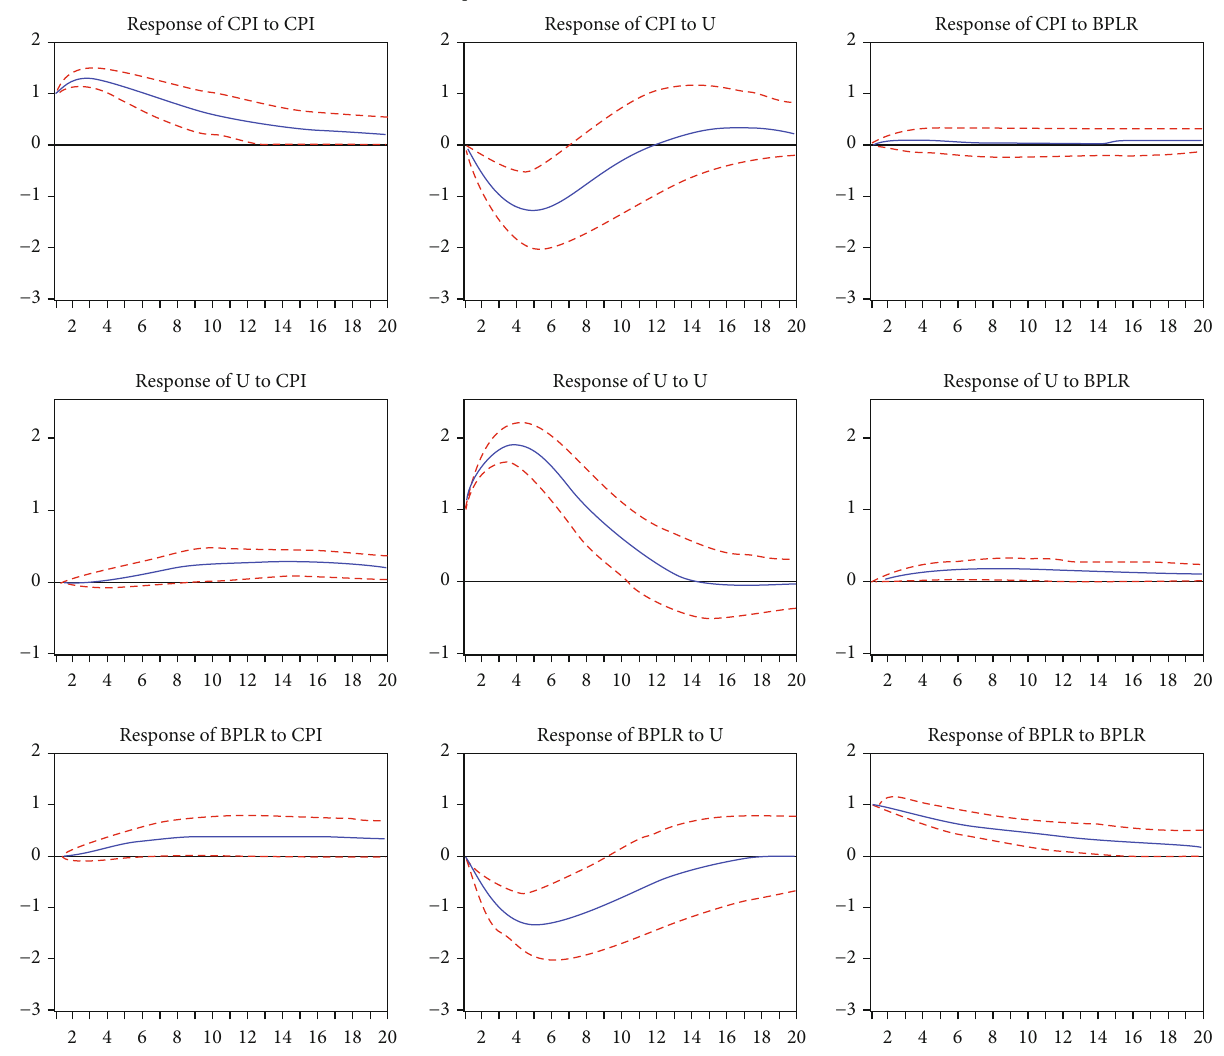
Figure 12: Impulse response functions (this chart comes from Egger et al.